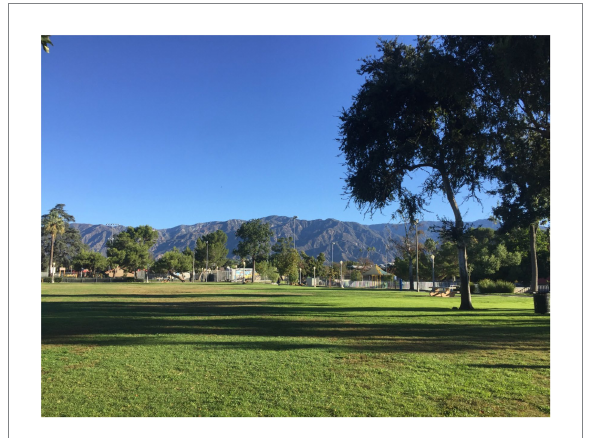
FIGURE 1 An example of an urban park included in this study (Villa Parke, City of Pasadena, Los Angeles County, California, United States). Photo credit, E.